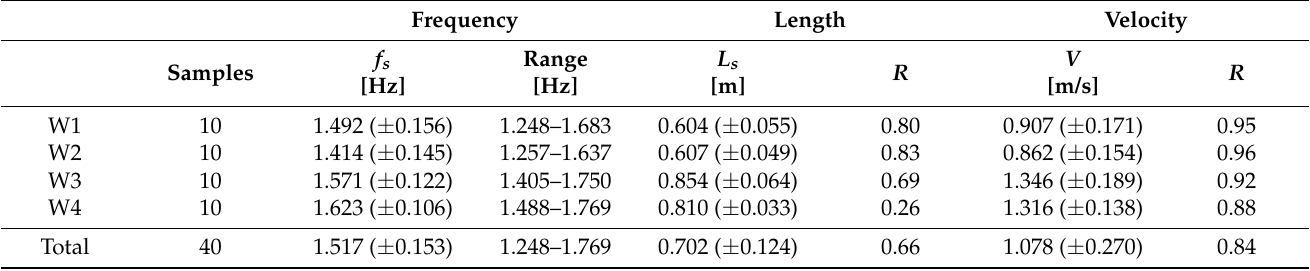
Figure 11. Summary of experimental records for W1–W4 configurations, as a function of calculated walking frequency: ( a ) peak of vertical acceleration, ( b ) average vertical acceleration, ( c ) peak-to-peak versus maximum acceleration. The 95% confidence interval is shown in grey colour. Table 2. Analysis of W1-to-W4 features (SLAB#1), with standard deviation in brackets and correlation coefficient R .